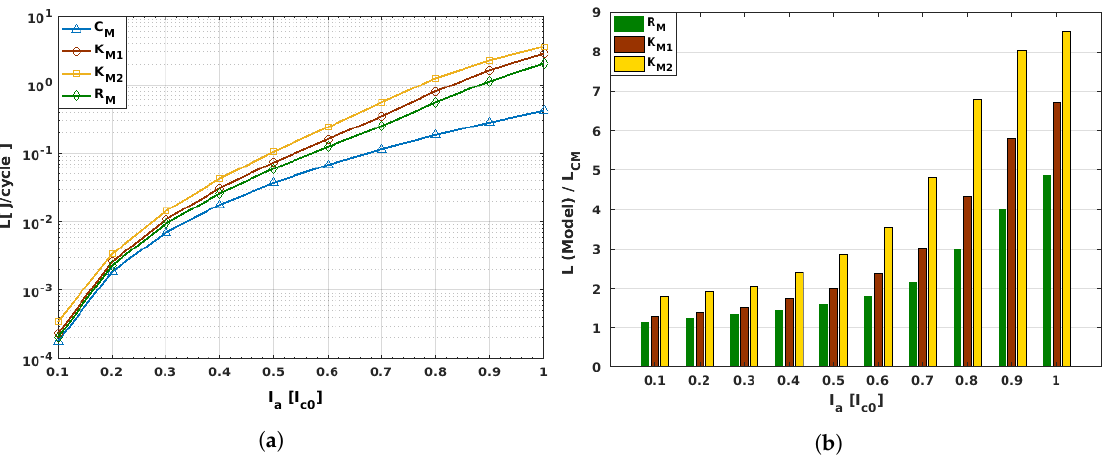
Figure 6. Presented as a function of the amplitude of the applied transport current, I a , and the material law models introduced in Table 1, in this figure we show ( a ) the predicted AC losses in Joules/cycle for a 20-turn SCS4050 racetrack coil, and ( b ) the relative difference between the Kim-based anisotropic models ( R M , K M 1 , and K M 2 ) and the magnetically isotropic C M